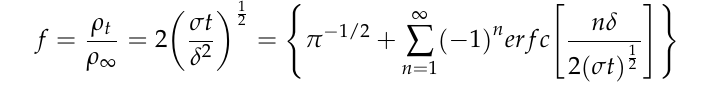
Figure 5. 5-fluorouracil release of experimental presentation [17]; the formulations are accommo- dated in multifractal theoretical replica (solid-colored lines). The legend of Figure 5, with the symbols for defining the experimental points and the colors for each type of fractal curve used in the case of the four tested substances, is presented above. As can be seen in Figure 5, from the graphic representation of cumula- tive drug release as a function of time, curves U 1 and U 4 are classic saturation curves, while curves U 2 and U 3 are increasing with time (tend to infinite values). 3. Evaluation of Polarized Optical Microscopy Pictures by Fractal Analysis